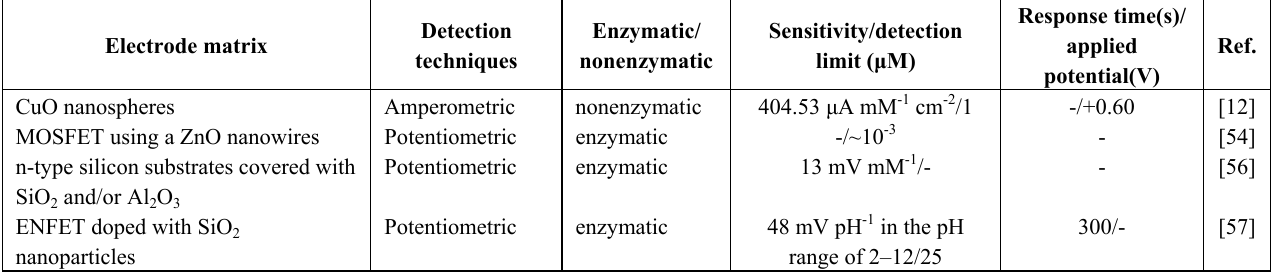
Table 1. Metal-oxides and metal-oxide composites available for glucose sensors and their functional